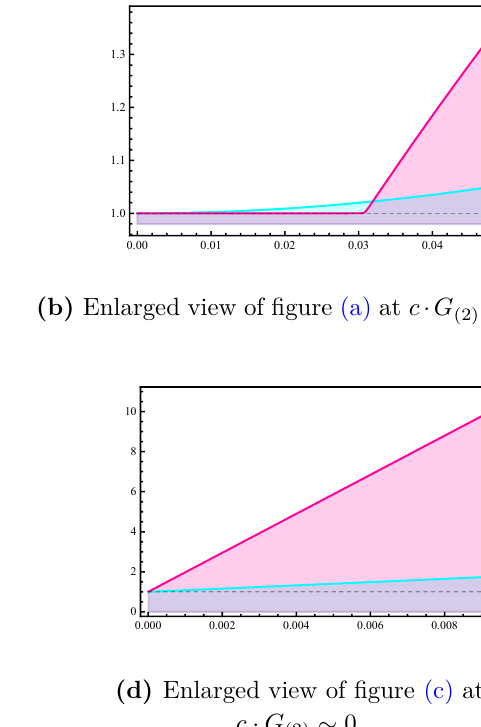
(d) Enlarged view of figure (c) at c · G ∼ 0 . (2) = 10 , L = 100 , h